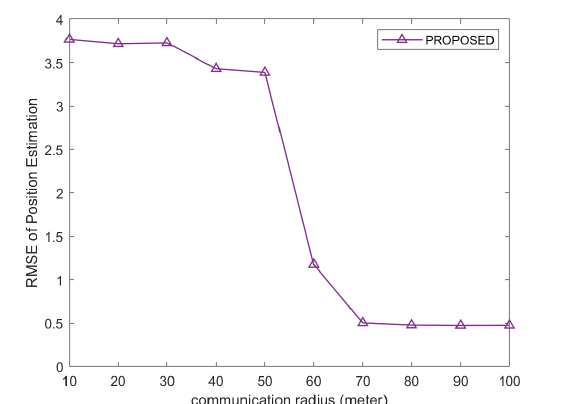
Figure 10. RMSE of position estimation versus communication